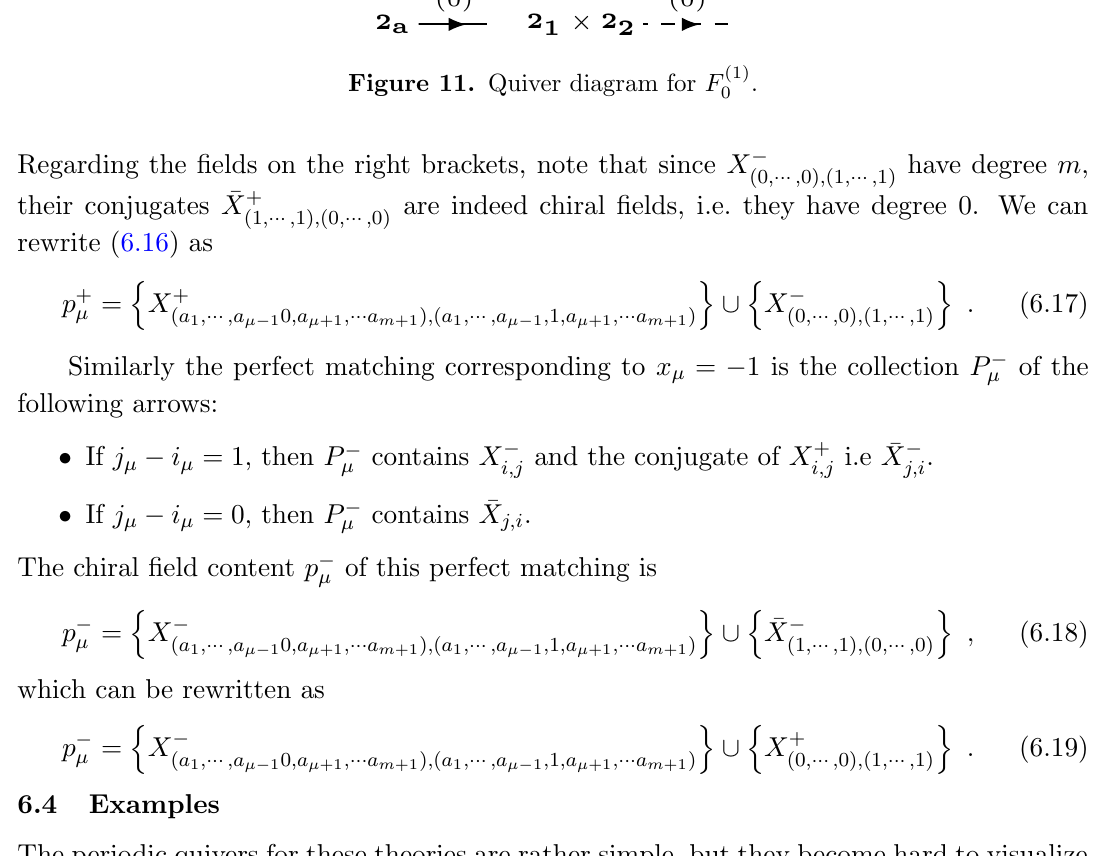
Figure 11. Quiver diagram for F (1)